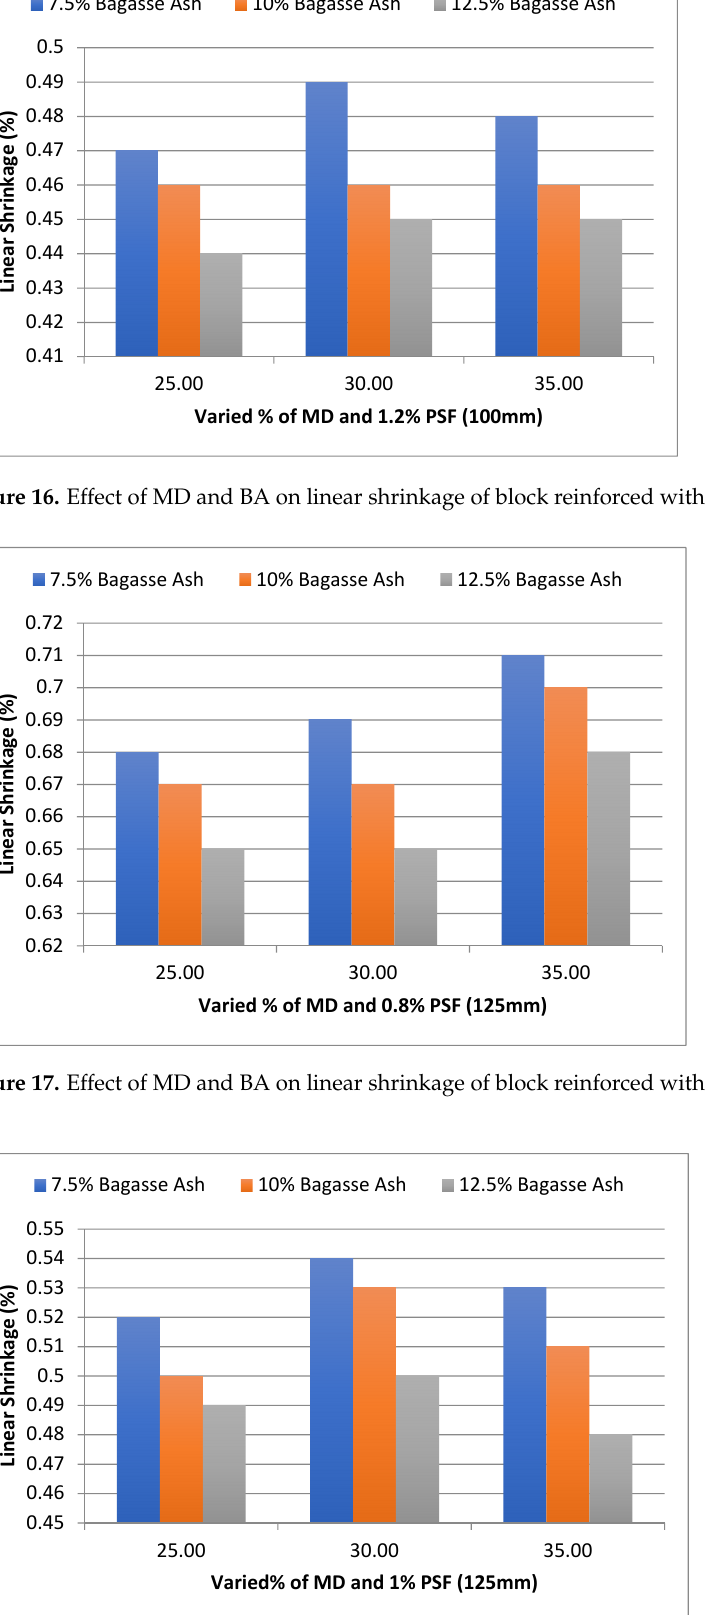
Figure 19. Effect of MD and BA on linear shrinkage of block reinforced with 1.2% PS fiber (125 mm). 3.3. Statistical Analysis Minitab 17.1 software was utilized for regression analysis, and a fit regression model was used for the generation of model equations, which were further used for optimiza ‐ tion. 3.3.1. Model Equation: Water Absorption versus x1, x2, x3, x4 The association between parameters and water absorption (WA) was developed us ‐ ing regression analysis, and the result is shown in Equation (3), a model equation to de ‐ termine WA of unfired soil block admixed with the varied proportion of PSF, MD, and BA: